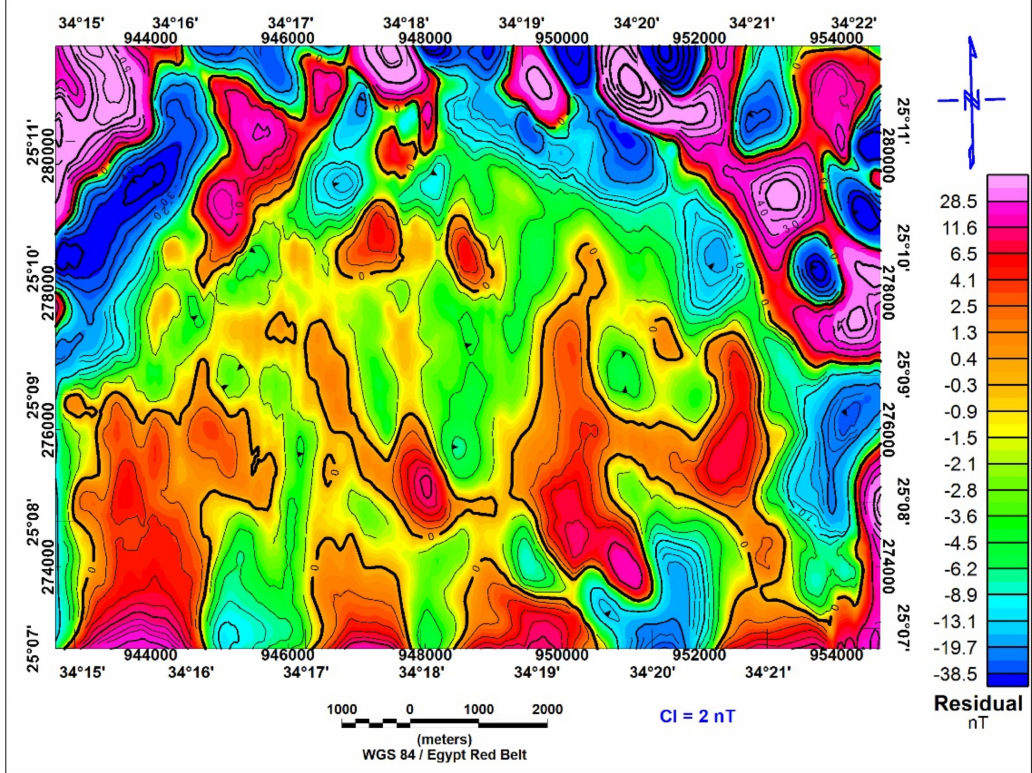
Figure 7. Residual airborne magnetic component of the RTP map of Homrit Waggat